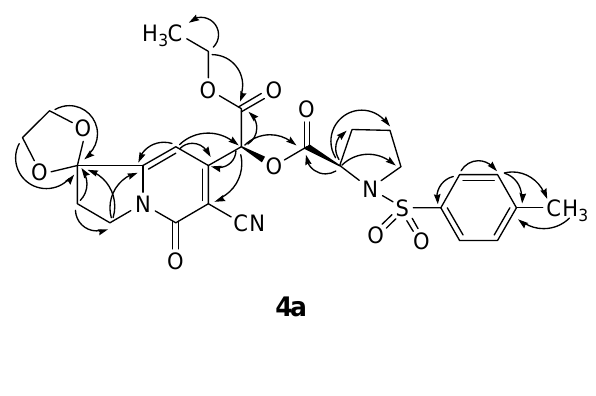
Figure 2. Important HMBC ( → ) correlations of compound